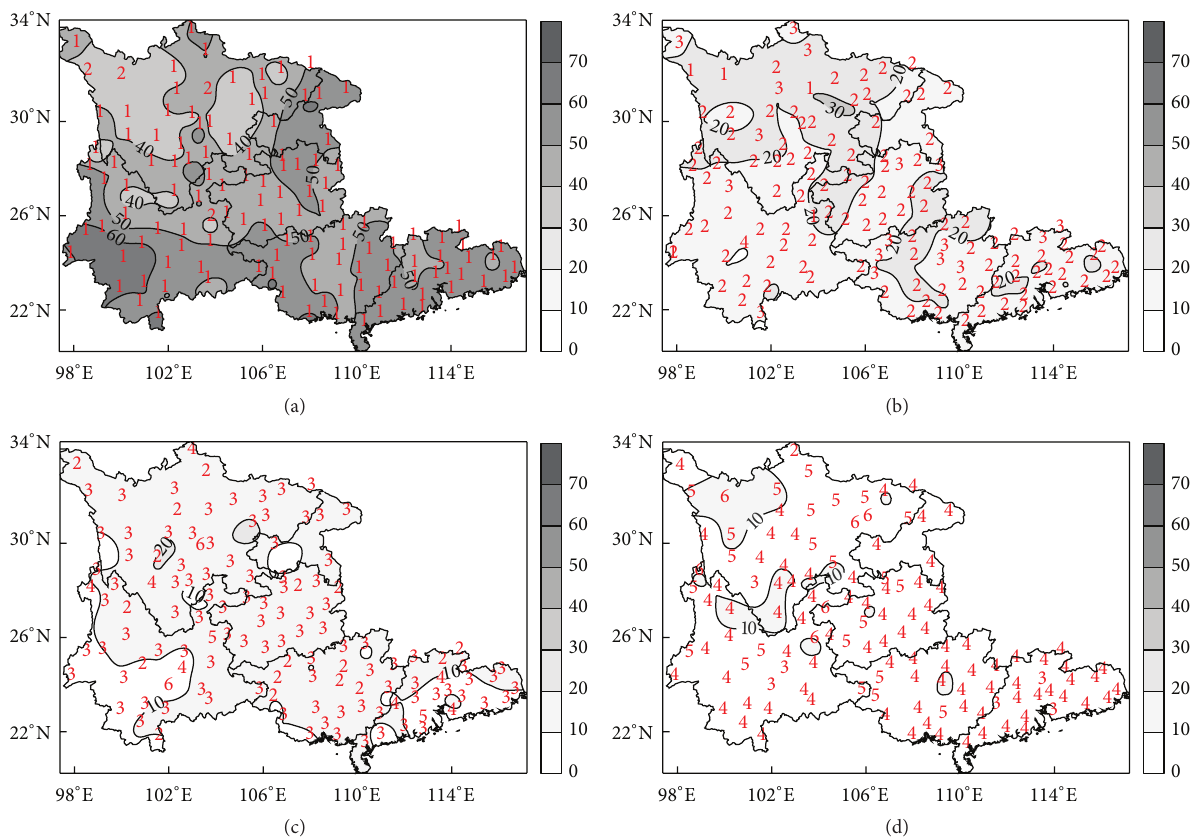
Figure 4: The first 4 cumulative timescales of precipitation deficit (red markers map, unit: month: (a) the first; (b) the second; (c) the third; (d) the fourth) and the proportion of droughts (blank map, unit: %) due to the deficits of each